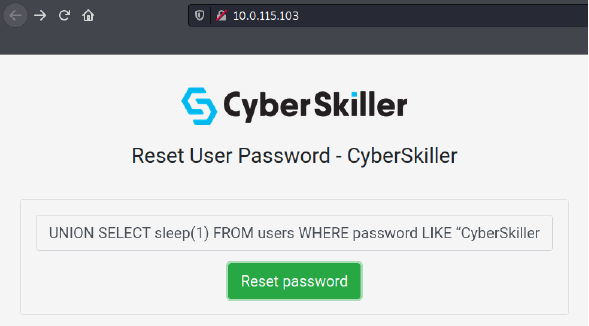
Figure 4. Exercise 4.5: Time-based SQL injection vulnerability